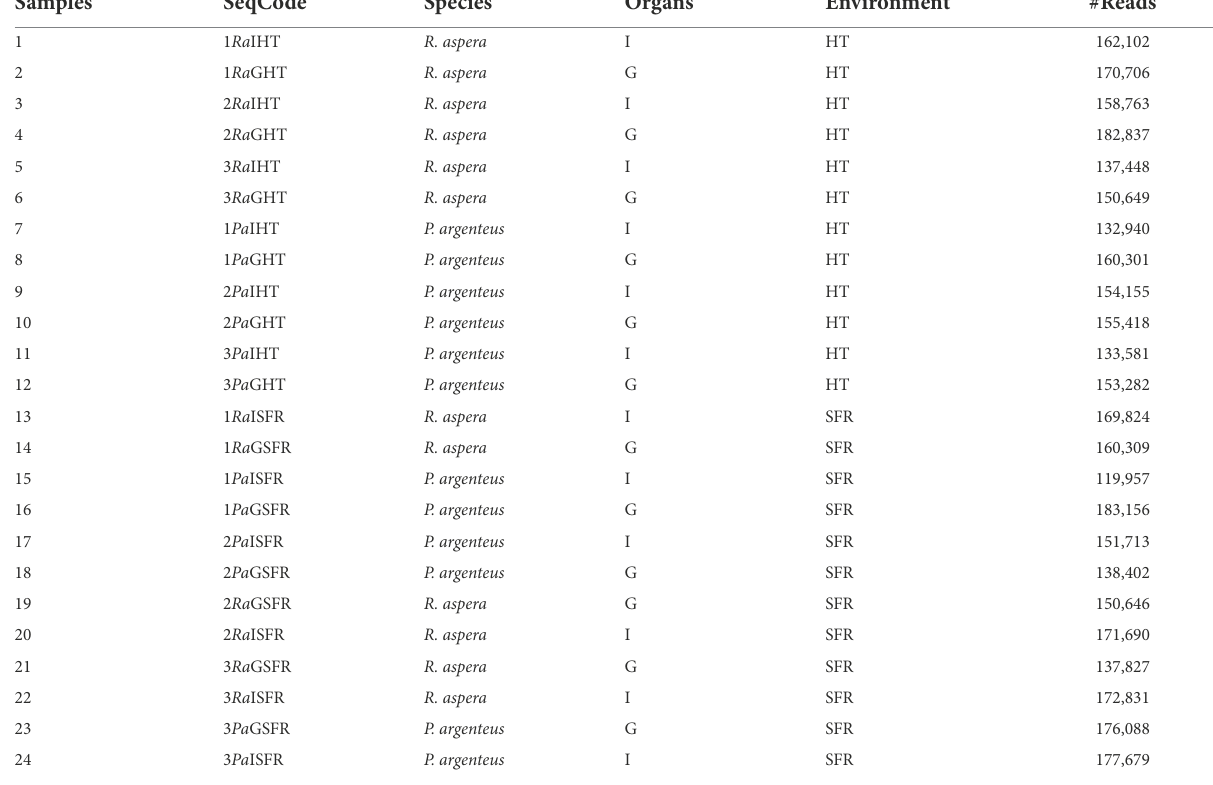
TABLE 1 Number and characteristics of samples obtained from R. aspera and P. argenteus collected in the SFR and HT.